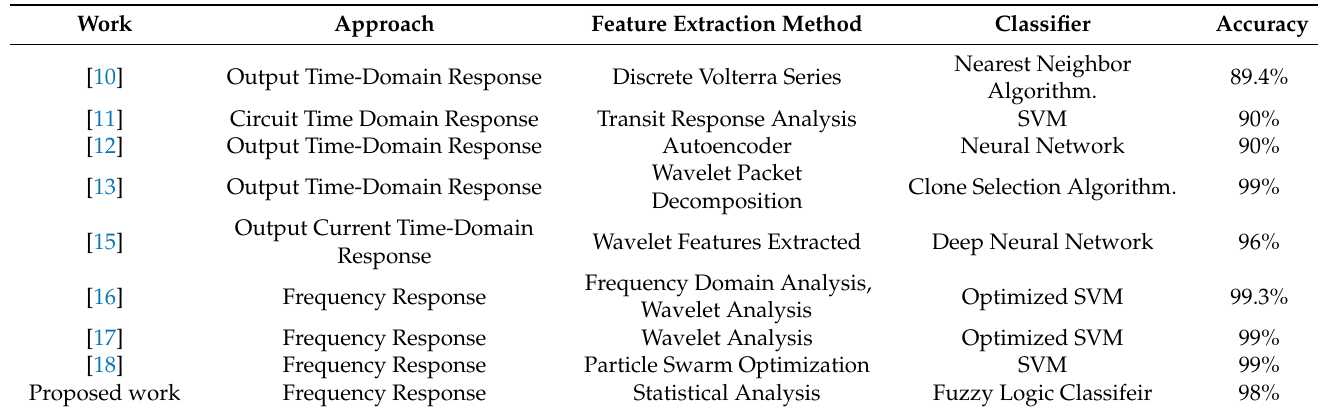
Table 5. A comparison between the proposed method and related